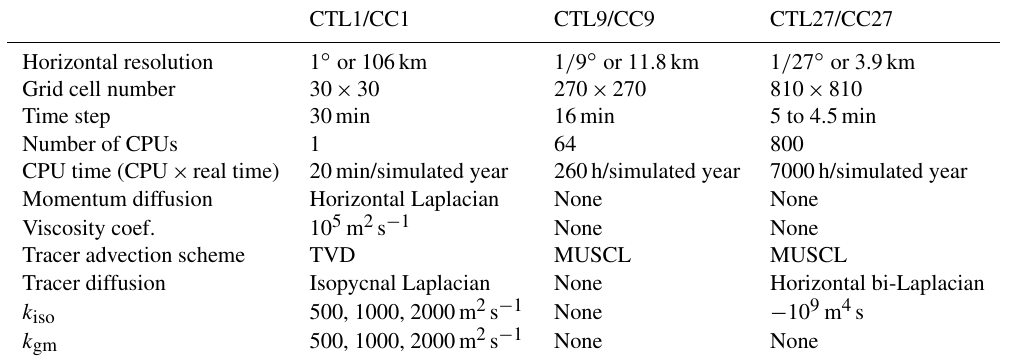
Table 1. Resolution-dependent model features and parameters. For details on numerical schemes see Madec et al. (2017) and Lévy et al. (2001). Note that we added a minimum level of bi-Laplacian tracer diffusivity at 1 / 27 ◦ to insure numerical stability, and this was not needed at the 1 / 9 ◦ resolution. This bi-Laplacian diffusion acts on the horizontal unlike the Laplacian diffusion acting along isopycnals in the 1 ◦ resolution